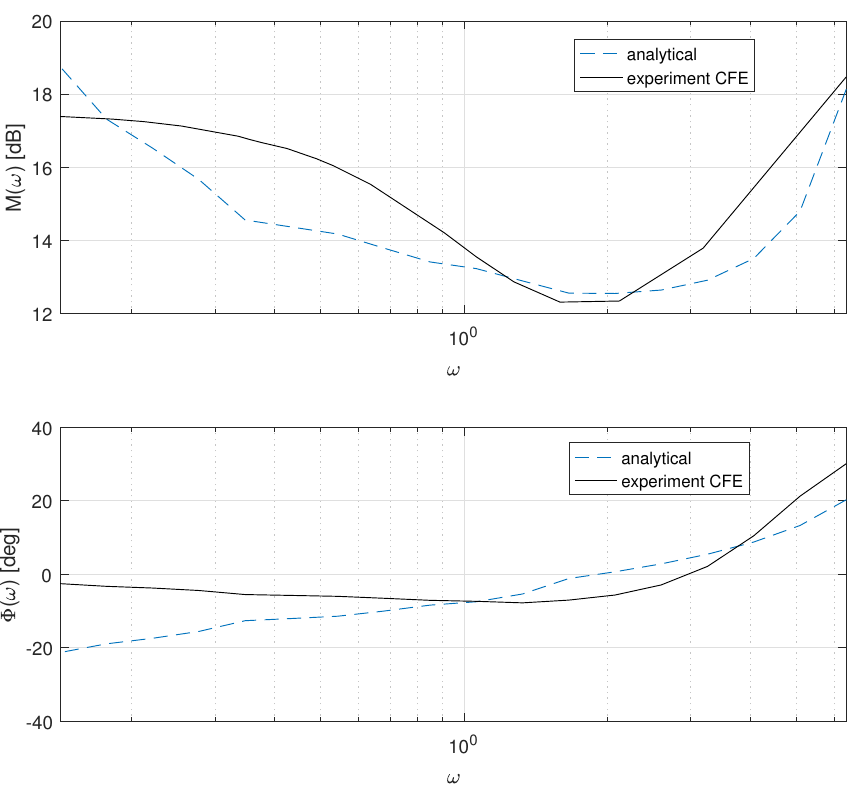
Figure 9. Comparison analytical Bode diagrams to experimental using CFE. α = β = 0.5. The comparison of step responses using CFE approximation vs. analytical responses are given in Figures 10–12. The analytical response was calculated using the